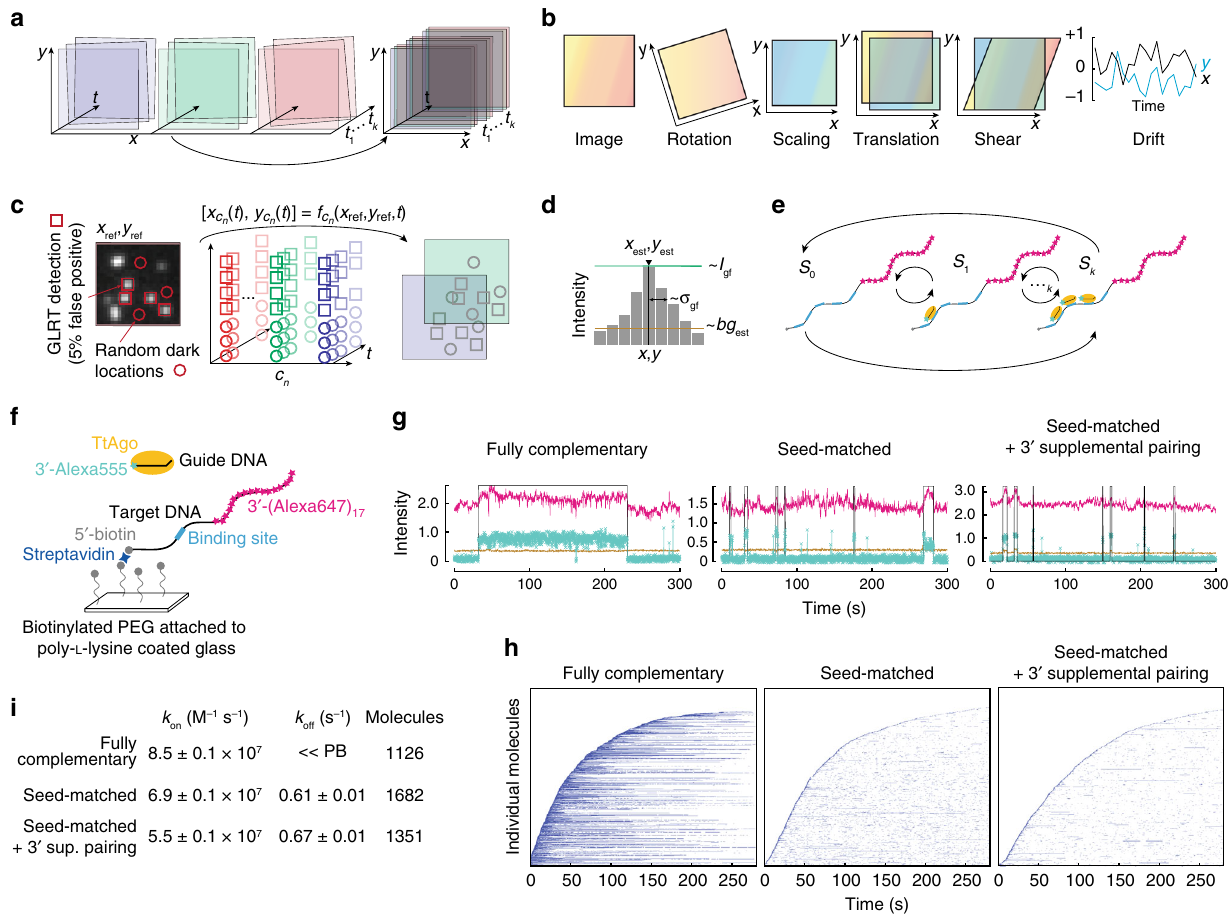
Fig. 1 Automated Bayesian single-molecule pipeline for binding assays. a Multiple color channels are registered and corrected for drift. b Estimated mapping between the colors is time-dependent and consists of rotation, scaling, translation, and drift. c Generalized likelihood ratio test (GRLT) is used to detect initial positions of target molecules ( x ref , y ref ) in one channel. These locations are then mapped to other channels c n ( n being number of the channel), and are extracted to estimate signal and background parameters. d Estimated parameters include the position ( x est , y est ), background bg est , intensity I gf and width σ gf of the single-molecule. e Variational Bayesian Evidence Maximization of Multivariate Gaussian Hidden Markov Model (VBEM-MGHMM) is used to cluster the complexity and estimate parameters of the underlying kinetics. S 0 , S 1 and S k are bound states 0, 1 and k , respectively. f Experimental set-up to measure TtAgo:guide interactions with target DNA. g Representative fl uorescence intensity time traces of TtAgo (turquoise) binding DNA target (magenta) with different extents of complementarity to the DNA guide. Light brown indicates background levels of green fl uorescence, whereas the black line denotes binding events detected by the pipeline after event fi ltering (minimal duration and gap closing; see User Manual — Co-localization analysis). Fluorescence intensity is expressed in thousands of photons. Increase in red fl uorescence correlated with the arrival of TtAgo:guide complex (green) is Förster resonance energy transfer (FRET) from the Alexa555 guide to the Alexa647 target. h Rastergram summary of traces of individual target molecules, each in a single row and sorted according to their arrival time, for different guide:target pairings. i Comparison of k on and k off of TtAgo with different targets. Values were derived from data collected from several hundred individual DNA target molecules (indicated as number of molecules); standard error from bootstrapping is reported. « PB: not determined because k off was slower than the rate of